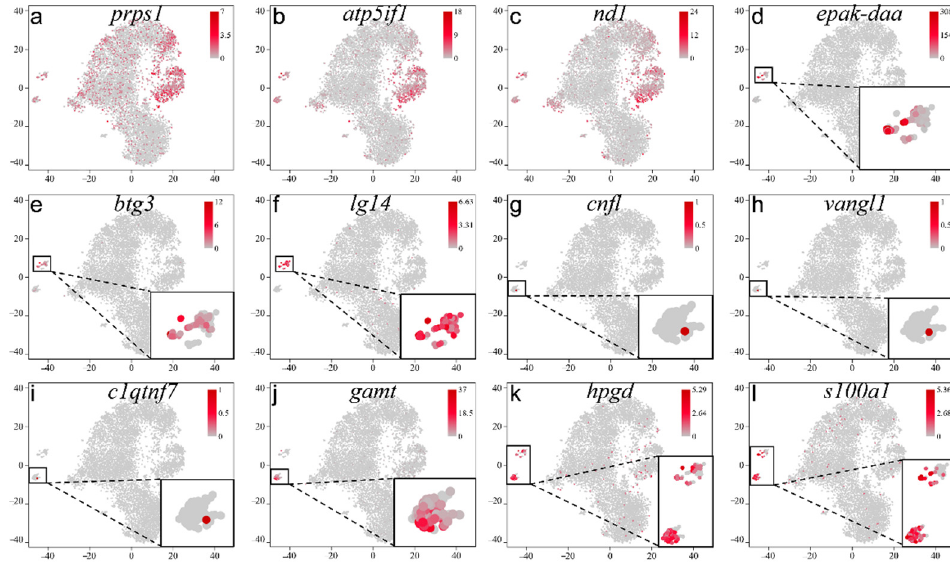
Figure 5. The selected marker genes located in all clusters visualized by t-SNE. ( a ) prps1 , ( b ) atp5if1 , ( c ) nd1 , ( d ) epak-daa , ( e ) btg3 , ( f ) lg74 , ( g ) cnfl , ( h ) vangl1 , ( i ) c1qtnf7 , ( j ) gamt , ( k ) hpgd , ( l ) s100a1 .